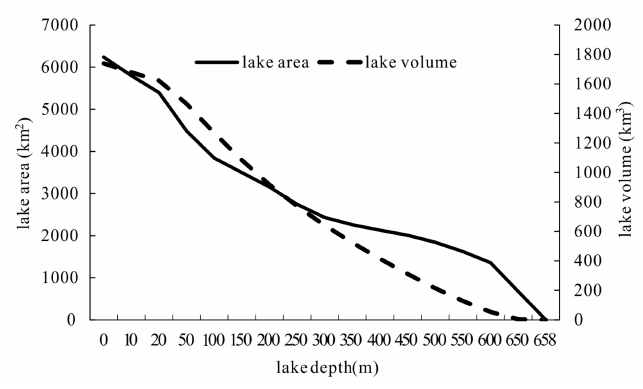
Figure 3. Variations of area and volume of Lake Issyk-Kul at different water depths (data sources from